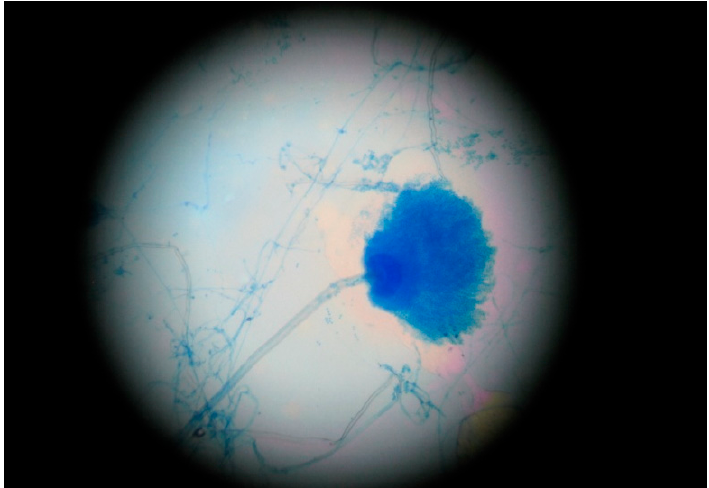
Figure 2. Aspergillus flavus , wet mount with methylene blue (cellophane tape mount), 400 × , Optic microscope (Karl Zeiss, Jena, Germany).